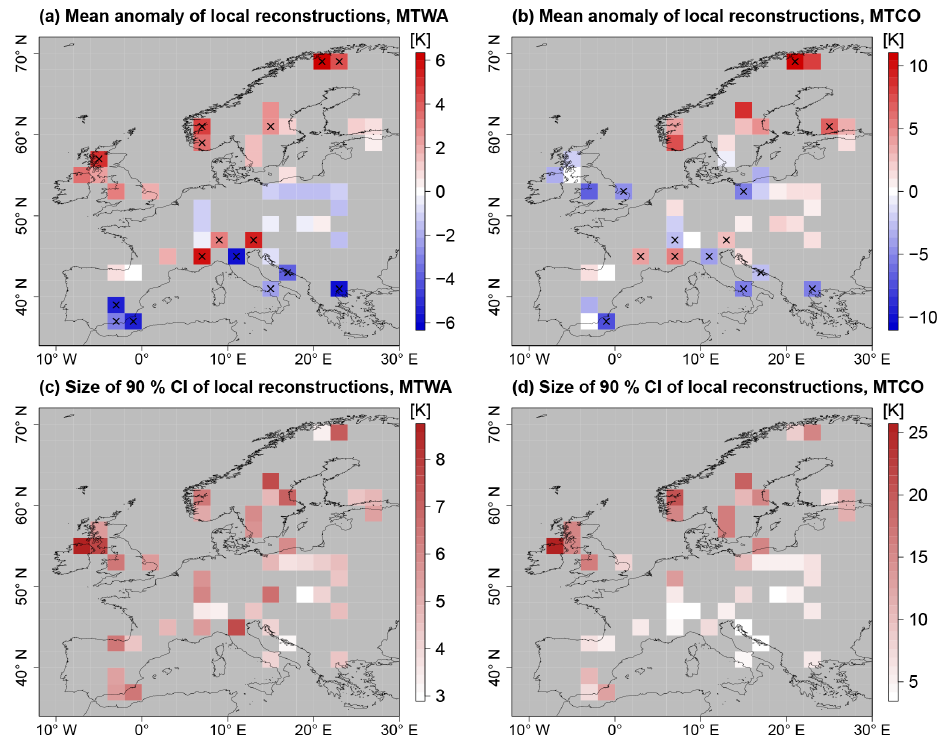
Figure 4. Summary statistics of local reconstructions using the PITM forward model. (a, b) Mean anomaly from CRU reference climatology; significant anomalies (5% level) are marked by black crosses. (c, d) Uncertainty measured by the size of marginal 90%